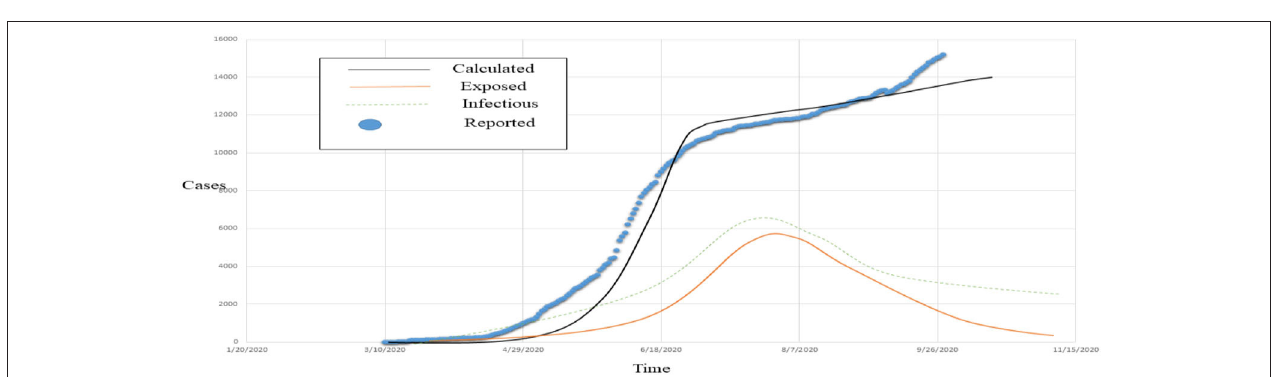
FIGURE 11 | Visualization of observed vs. estimated COVID-19 cases.